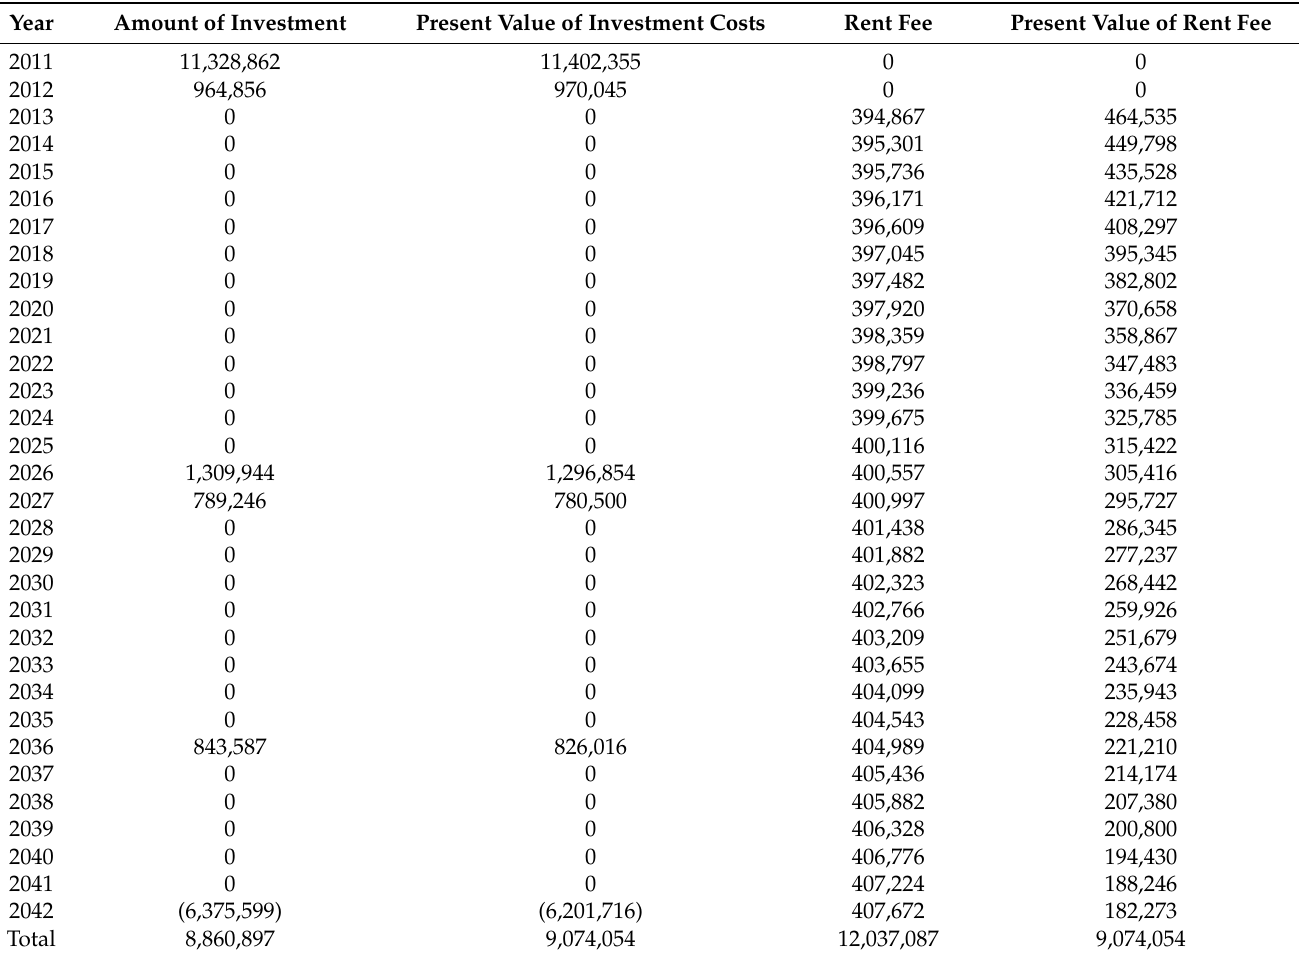
Table 3. Proper rent fee from the perspective of investment cost recovery (units: U.S.